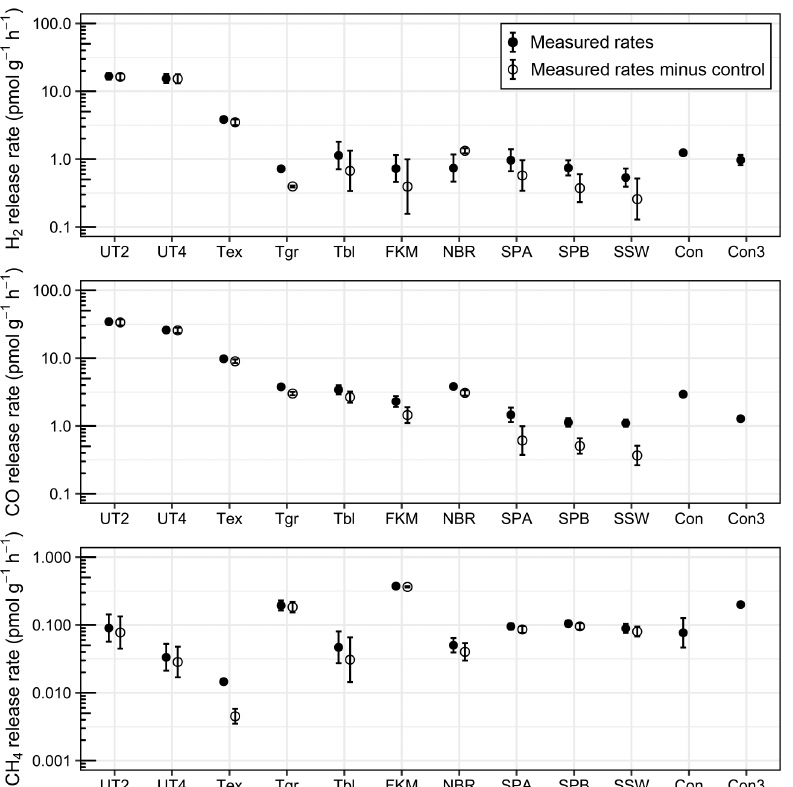
Figure 3. Rates of trace-gas release from various rubber materials in 3mL (Con3) and 12mL (all other treatments) Exetainers ( n = 4), normalised to mass. Error bars denote standard error of the mean. Please refer to Fig. 2 for the treatment